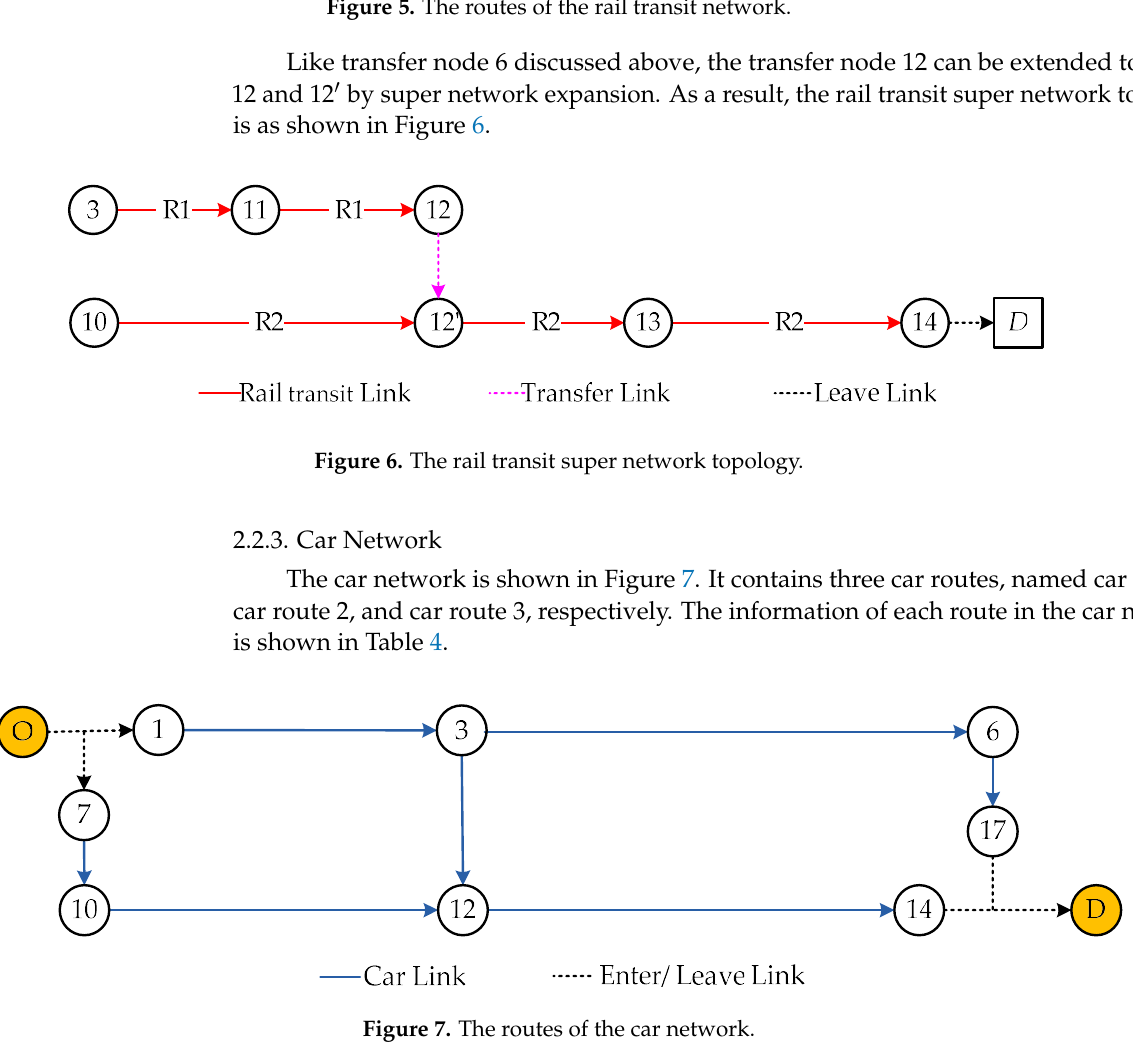
Figure 5. The routes of the rail transit network.